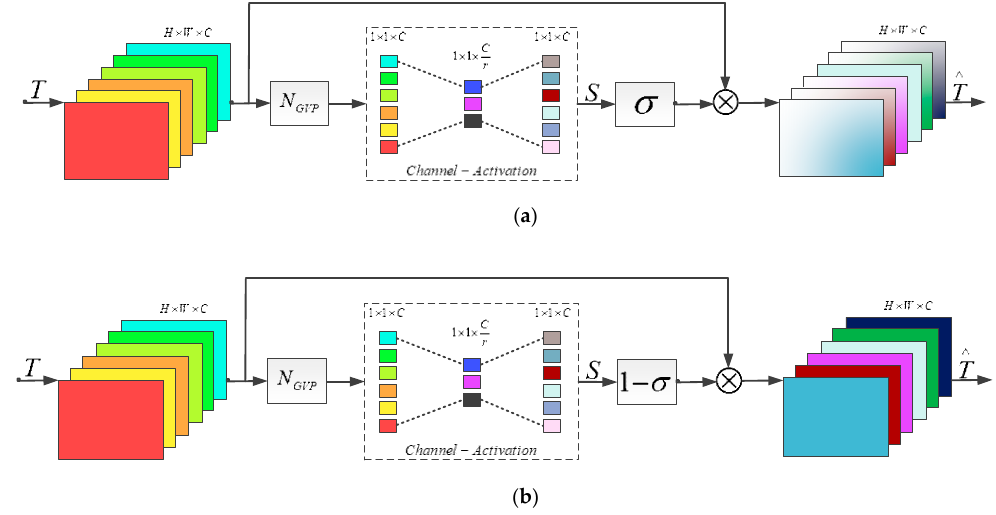
Figure 6. Details of channel attention block (CAB) of variance (VCA) which categorize CA-H and CA-L. ( a ) channel-wise attention block based on high variance (CA-H); ( b ) channel-wise attention block based on low variance